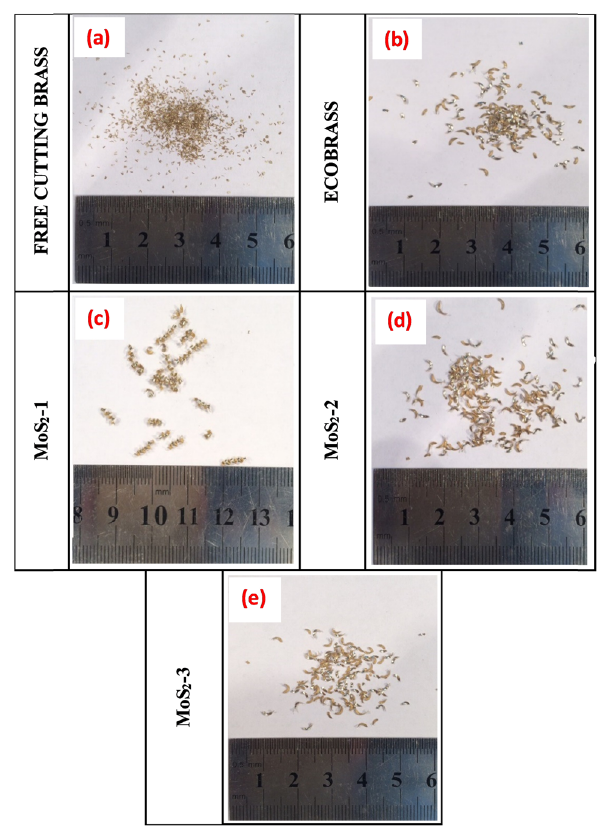
Figure 7: Macrographs of chip formation for ( a ) F.C.B; ( b ) Ecobrass; ( c ) MoS - 1; ( d ) MoS - 2; and ( e ) MoS 2 2